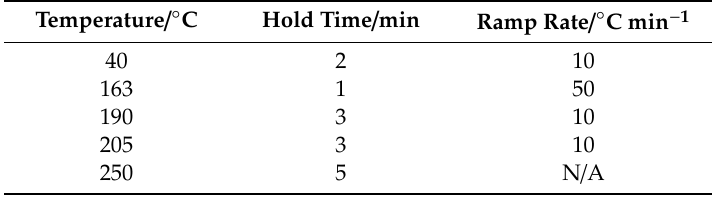
Table 6. Method used for analysis of products of glycerol upgrading reaction in the